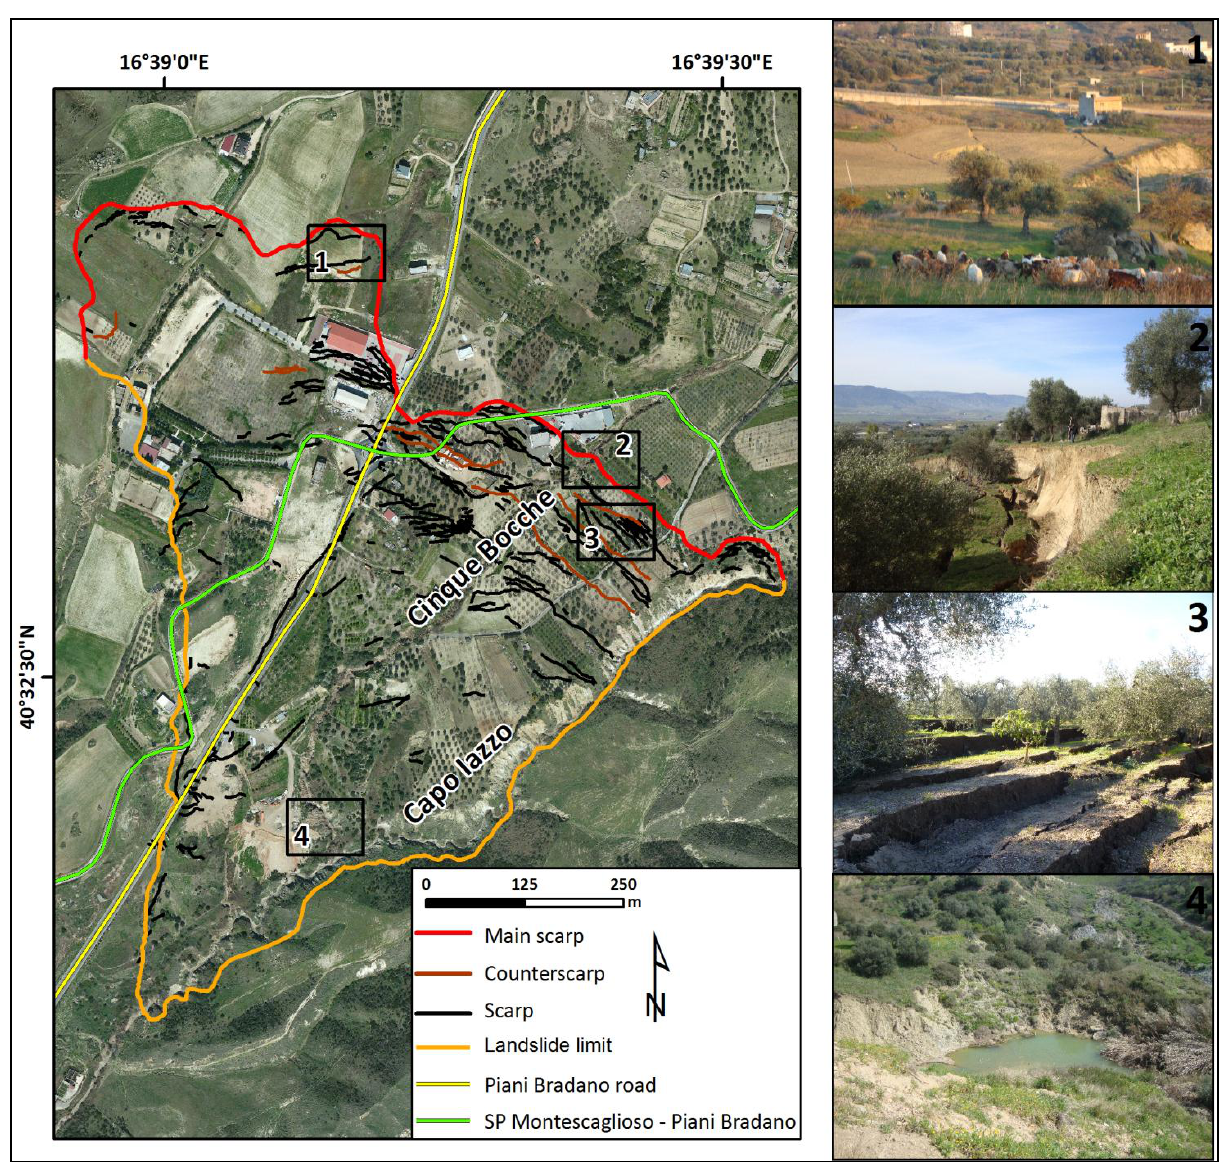
Figure 3. The 3 December Montescaglioso landslide. In the insets, field evidences of deformation are reported: ( 1 ) graben -type feature in the upper sector of the slope; ( 2 ) main scarp; ( 3 ) set of scarps and counterscarps; ( 4 ) landslide pond at the confluence between the Cinque Bocche and Capo Iazzo